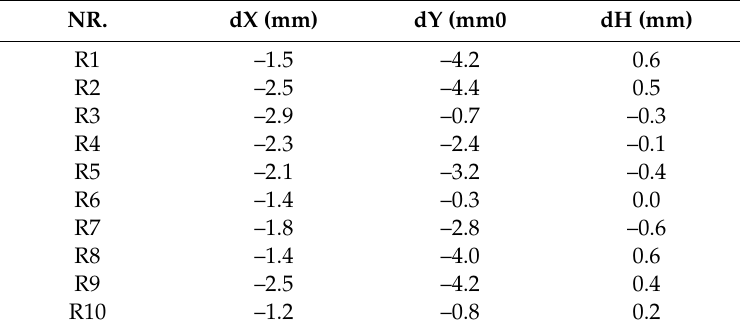
Table 3. Filling related